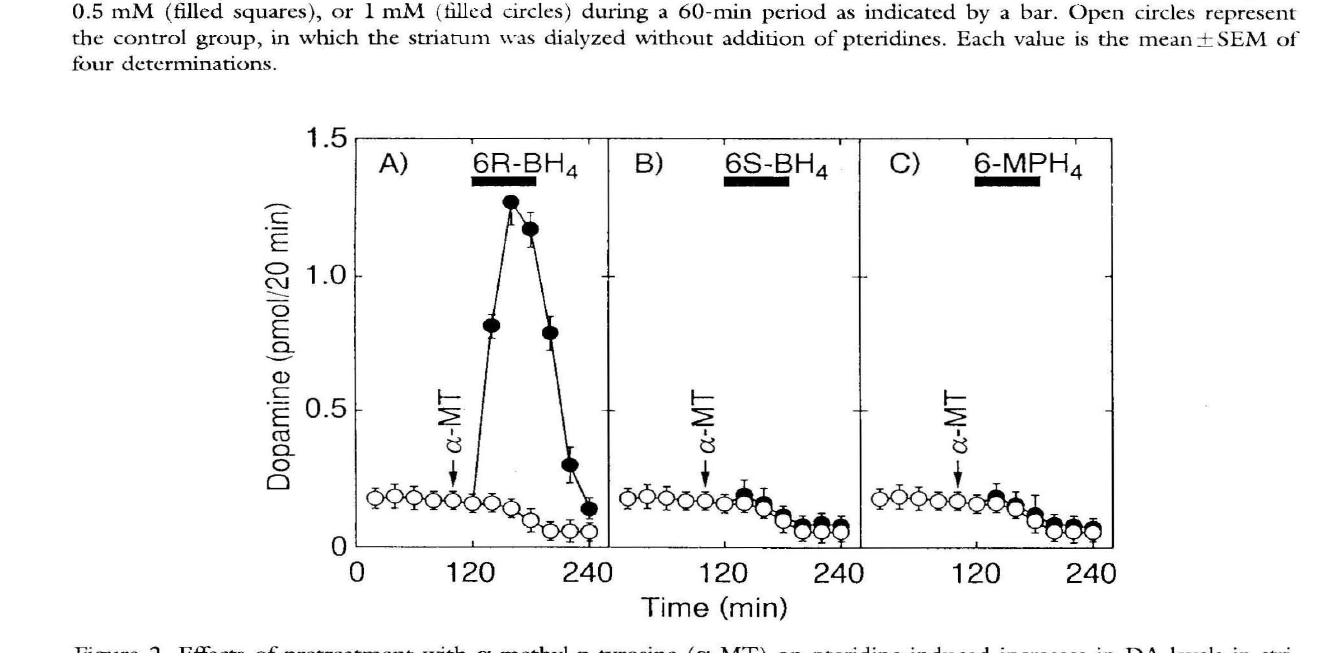
Figure 2. Effects of pretreatment with a-methyl-p-tyrosine (a-MT) on pteridine-induced increases in DA levels in stri atal dialysates. Twenty minutes after i.p.administration of 250 mg/kg of a -MT (indicated by arrows), either 6R-BH. (A) 6S-BH. (B) or 6-MPH. (C) was added to the perfusion fluid of microdialysis at a final concentration of 1 mM (filled circles) during a 60-min period as indicated by a bar. Open circles represent the control group, which was given a-MT alone. Each value is the mean±SEM of four determinations.